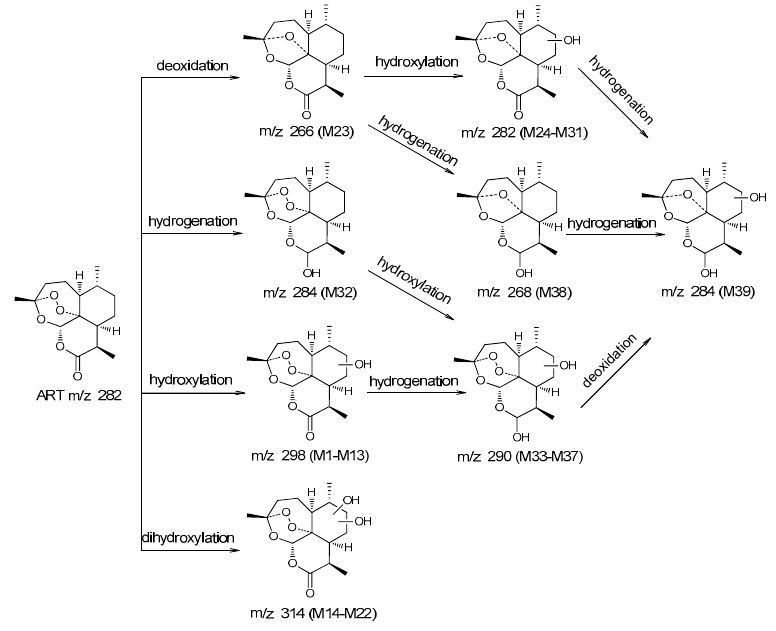
Figure 4. Proposed metabolic pathways of ART.